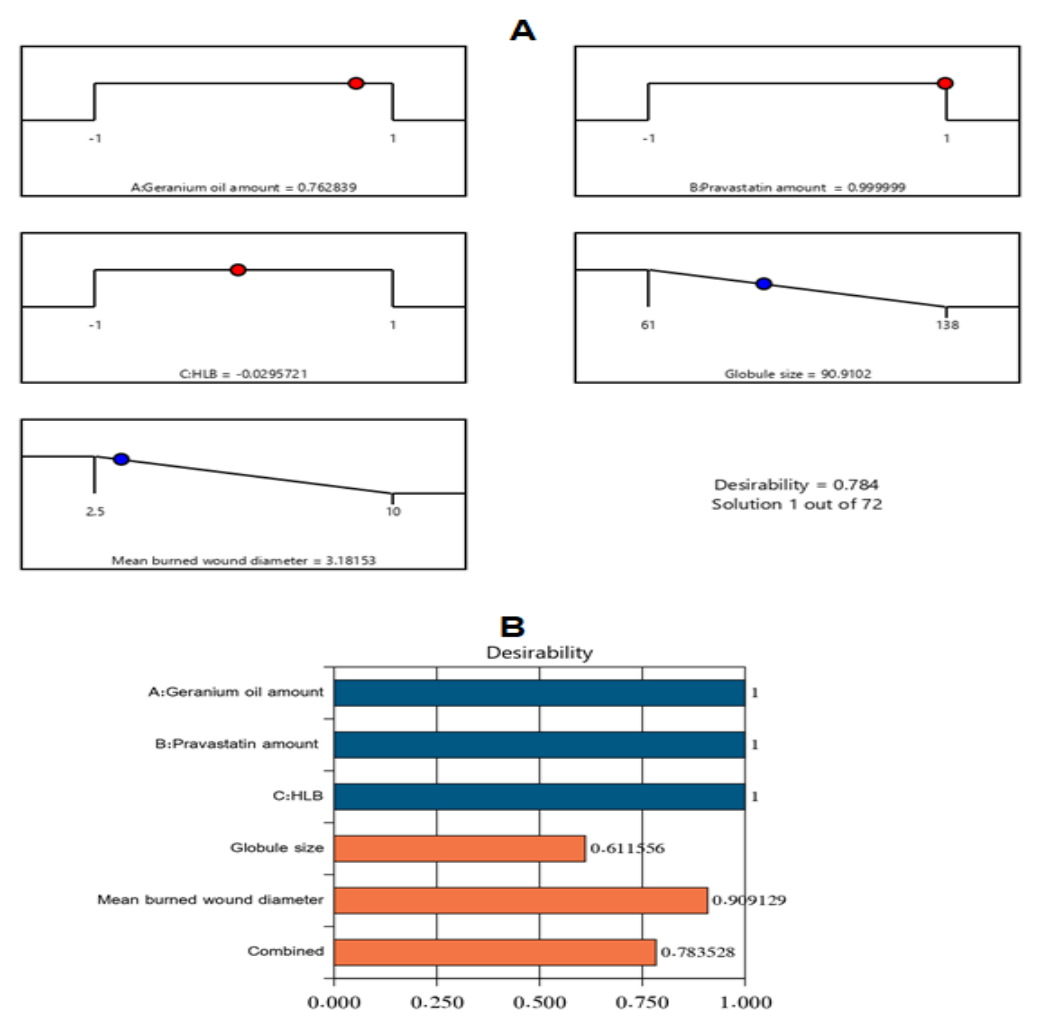
Figure 3. Desirability ramp and bar chart for optimization. ( A ) The desirability ramp shows the levels of independent variables and predicted values for the responses of the optimum formulation. ( B ) The bar chart shows the desirability values for the combined responses.